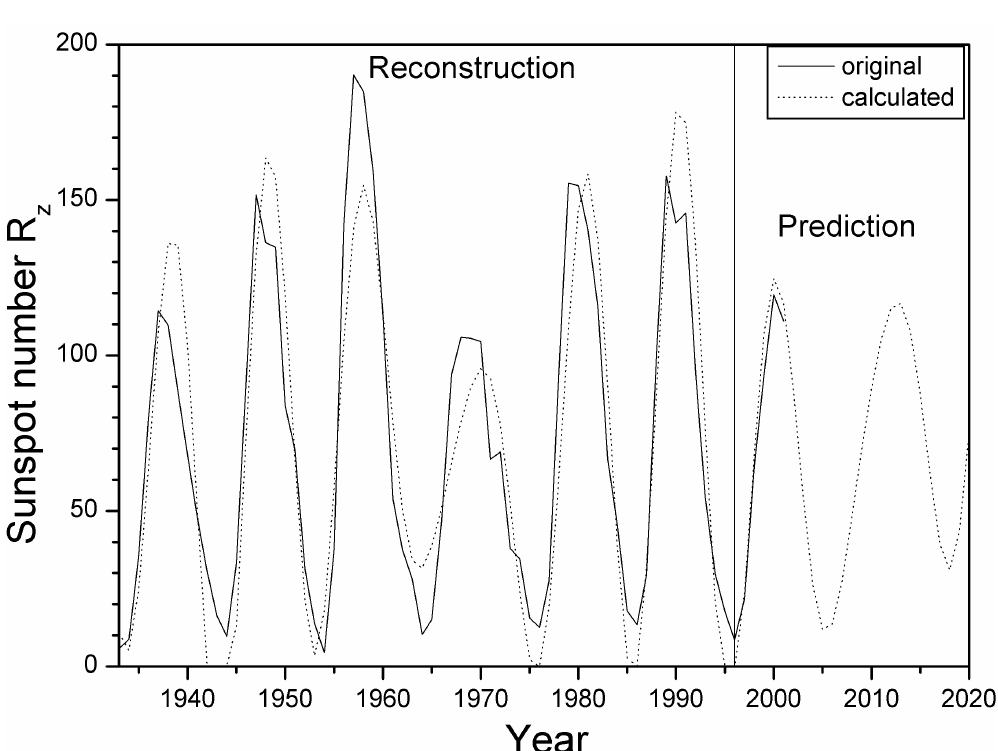
Fig. 1. Sunspot number time series in the period 1850–2000.